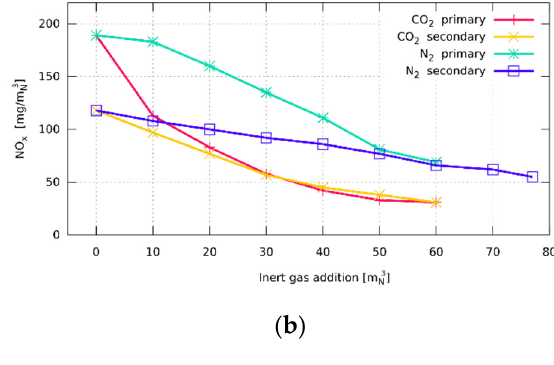
10 of 18 Table 7. Experimental matrix—TEST A—Burner C. Regime